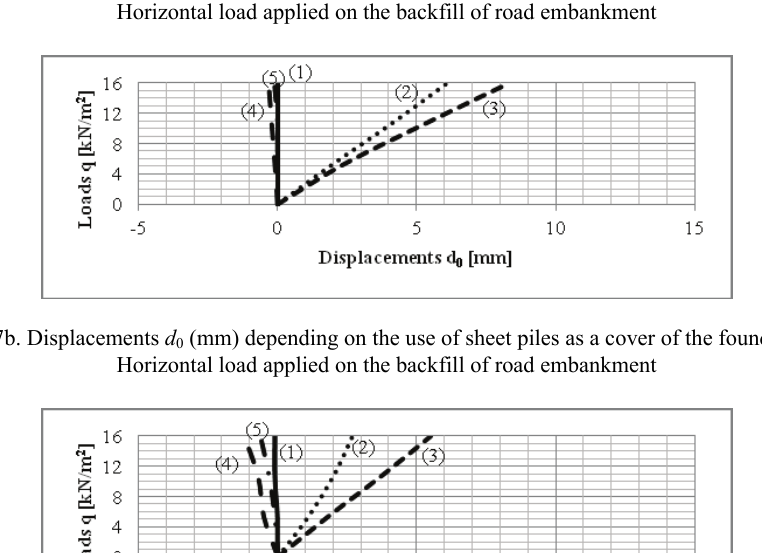
Fig. 7a. Displacements d 1 (mm) depending on the use of sheet piles as a cover of the foundation. Horizontal load applied on the backfill of road embankment